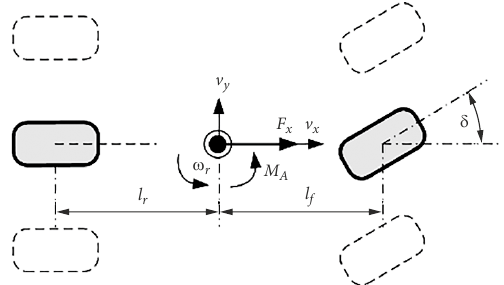
Figure 4. Single-track model (source: created by the